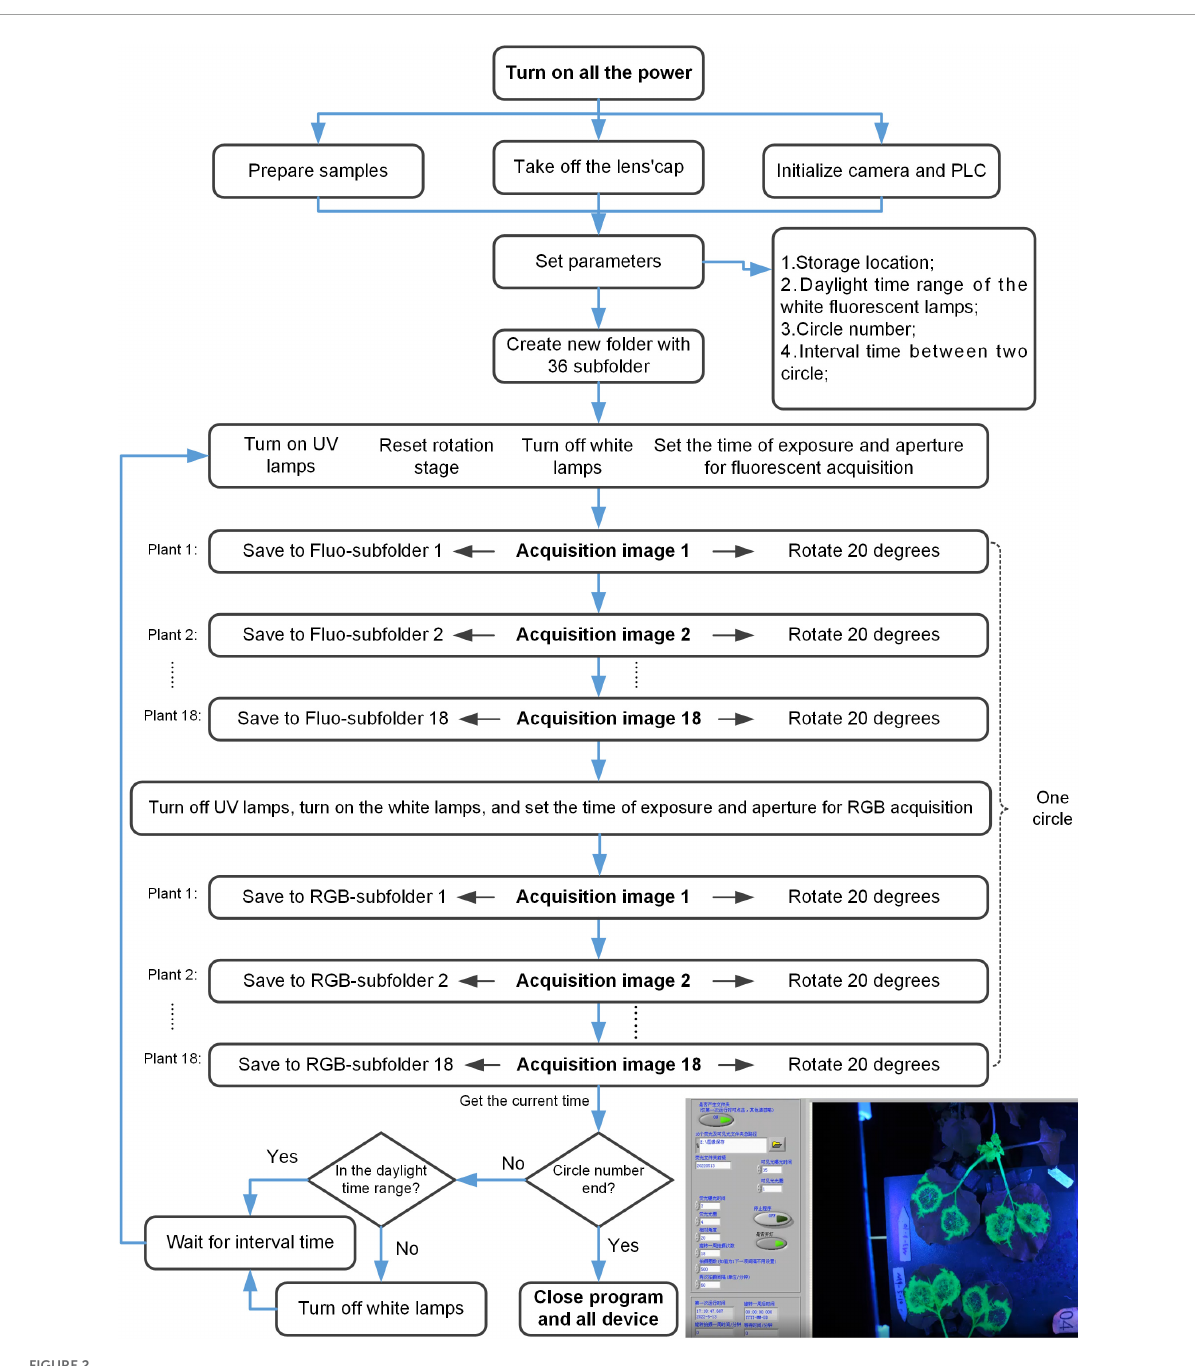
FIGURE2 Diagram of control and data acquisition for the fluorescence phenotyping platform.